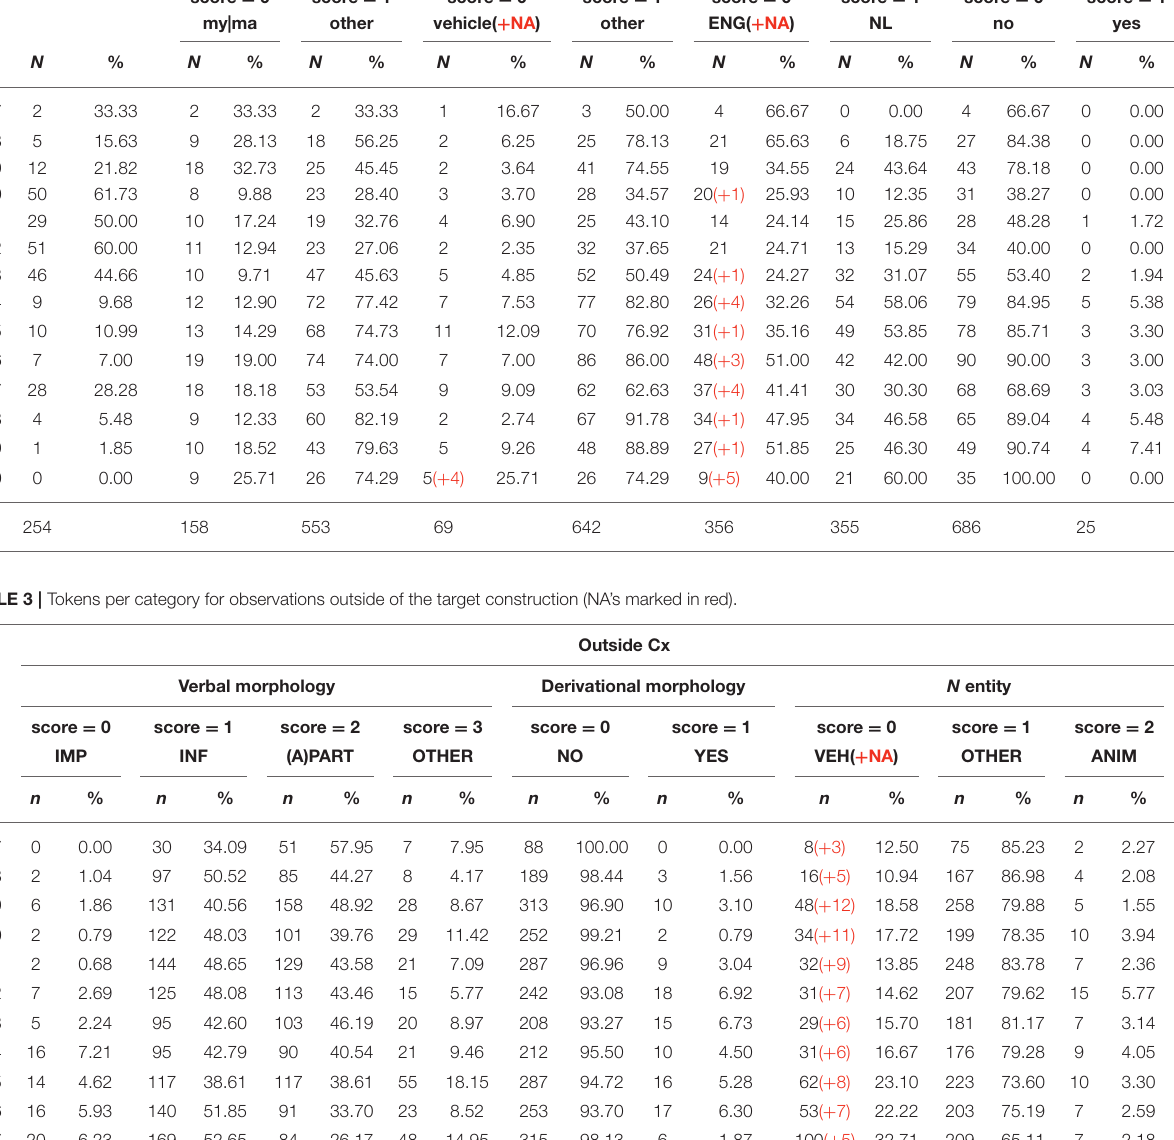
TABLE 2 | Tokens per category for observations of “pimp my ride” and of the target construction [ pimp POSS N] (NA’s marked in red). Pimp My Ride